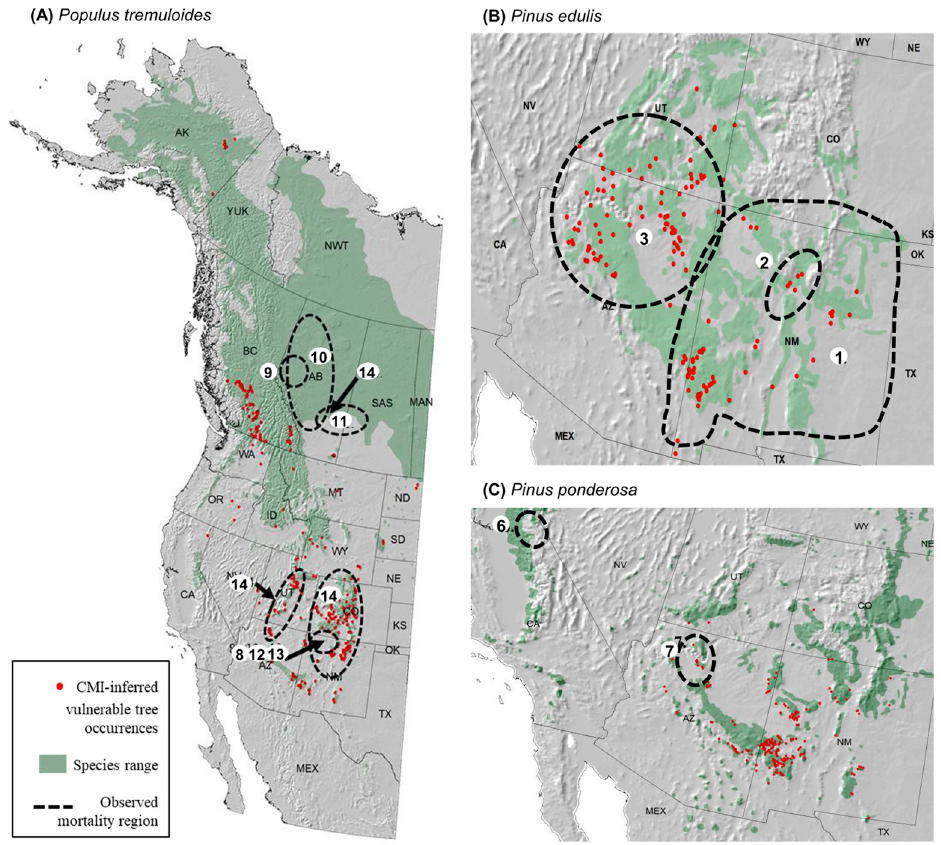
Figure 3. Plot locations identified as potentially vulnerable to drought based on a climate moisture index (CMI) versus documented dieback and mortality for three forest tree species: ( A ) aspen, ( B ) Colorado pine, and ( C ) ponderosa pine. Numbers refer to reference IDs that document the drought impacts [10,12,14,22,32–42] , listed in Appendix B, Table A1.